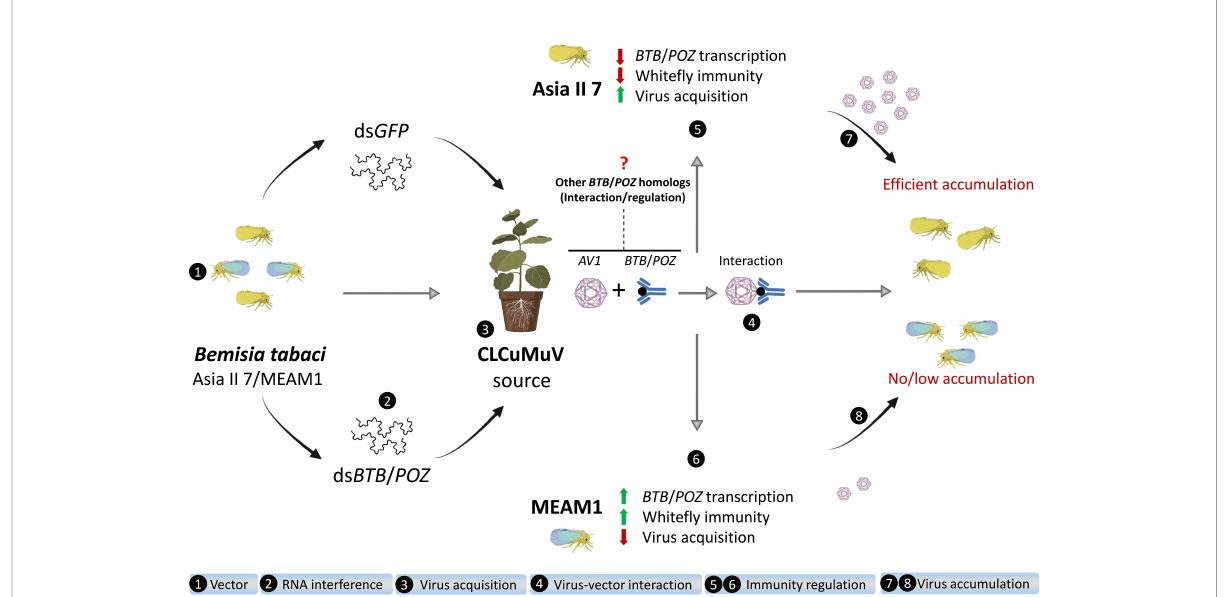
FIGURE 9 A schematic diagram depicting experimental procedures and the role of CLCuMuV in differential regulation of white fl y antiviral